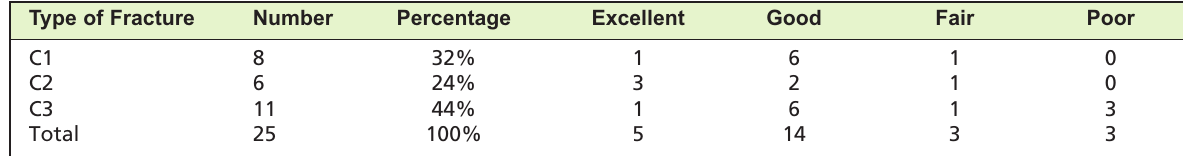
Results according to classification of the fracture Table III: